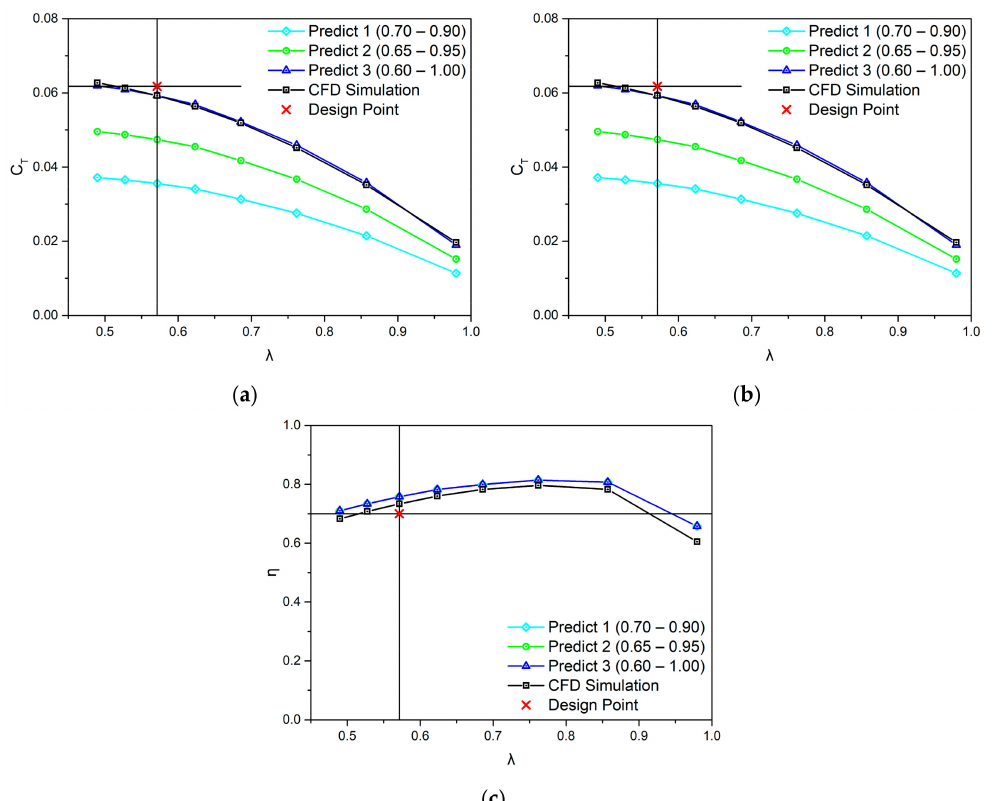
Figure 19. Comparison of predicted performance with results of CFD simulation: ( a ) thrust coefficient; ( b ) power coefficient; ( c ) efficacy.